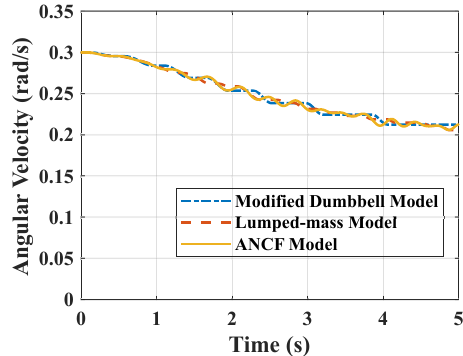
Figure 11. Angular velocity of the target.